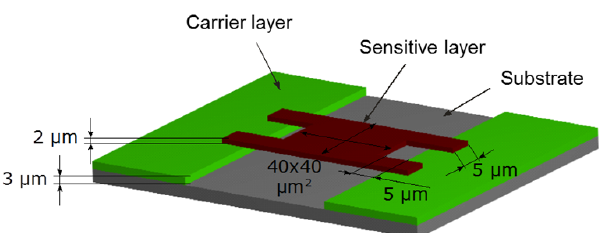
1 Figure 2. Geometric target parameters for the microbolometer pixel Figure 2. Geometric target parameters for the microbolometer pixel to be realized. 2 to be